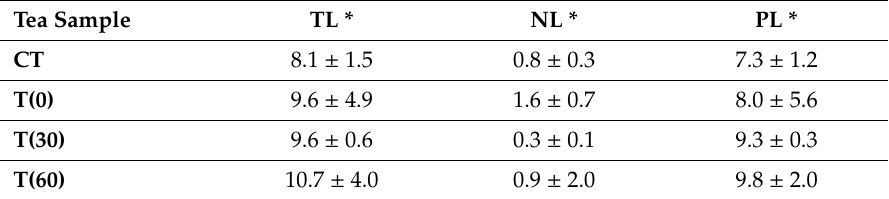
Table 1. Yield of extraction of lipid content (TL, PL, and NL) of the tea samples before (0 min) and after 30 and 60 min of oxidation in comparison with commercial